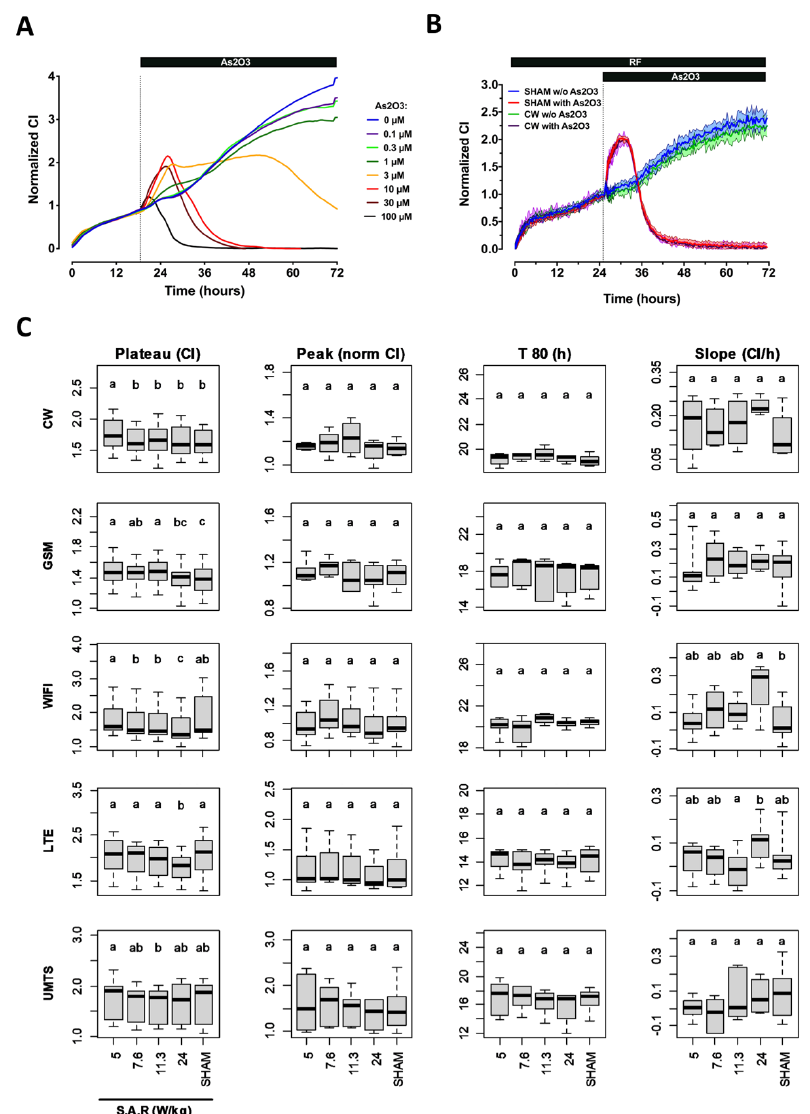
Figure 1. Characterization of the response of SH-SY5Y cells under RF exposure alone or under co-exposure to RF and As 2 O 3 . ( A ) Characterization of the normalized CI temporal signature of SH-SY5Y cells challenged with increasing concentrations of As 2 O 3 . The vertical dashed line indicates the time at which cells were either mock-challenged or challenged with the indicated concentration of As 2 O 3 . The data represent the average of four independent experiments. For better clarity, the measurement error is not represented. ( B ) Example of the CI temporal signature recorded from SH-SY5Y cell cultures that were either sham-exposed or exposed to unmodulated 1800 MHz (CW signal) at 24 W/kg. The vertical dashed line indicates the time at which cells were either mock- challenged or challenged with 10 µ M As 2 O 3 . The data represent the average of four independent experiments ± SEM values. ( C ) Statistical analysis of the effect of CW, GSM, Wi-Fi, LTE, and UMTS- modulated 1800 MHz signals emitted at either 5, 7.6, 11.3, or 24 W/kg on four metrics describing SH-SY5Y cells impedance measurement in the absence or presence of As 2 O 3 . First left column: average CI measured during the 5 h preceding injection of As 2 O 3 or buffer. Second column to the left: magnitude of the CI increase in response to As 2 O 3 . Third column to the left: time at which 80% of the cell population died following As 2 O 3 injection. Last column on the right: cell proliferation rate at day 3 in the absence of As 2 O 3 . The number of replicates per condition is indicated in Supplementary Table